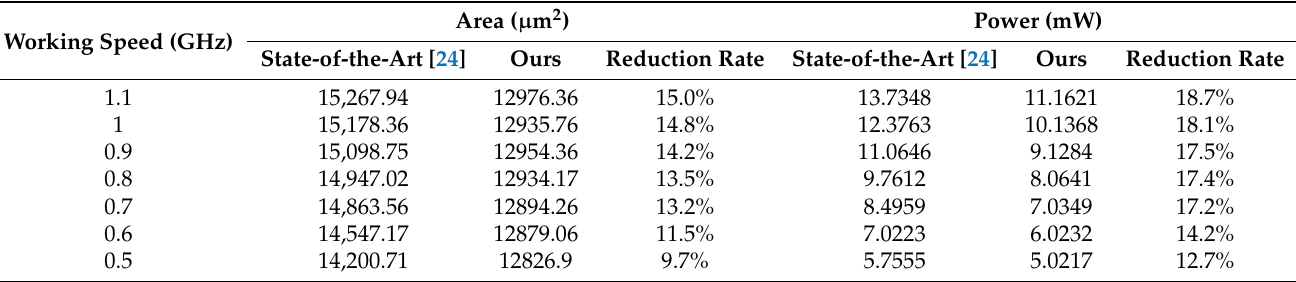
Table 6. Comparisons on different 3 × 3 CA-O designs.